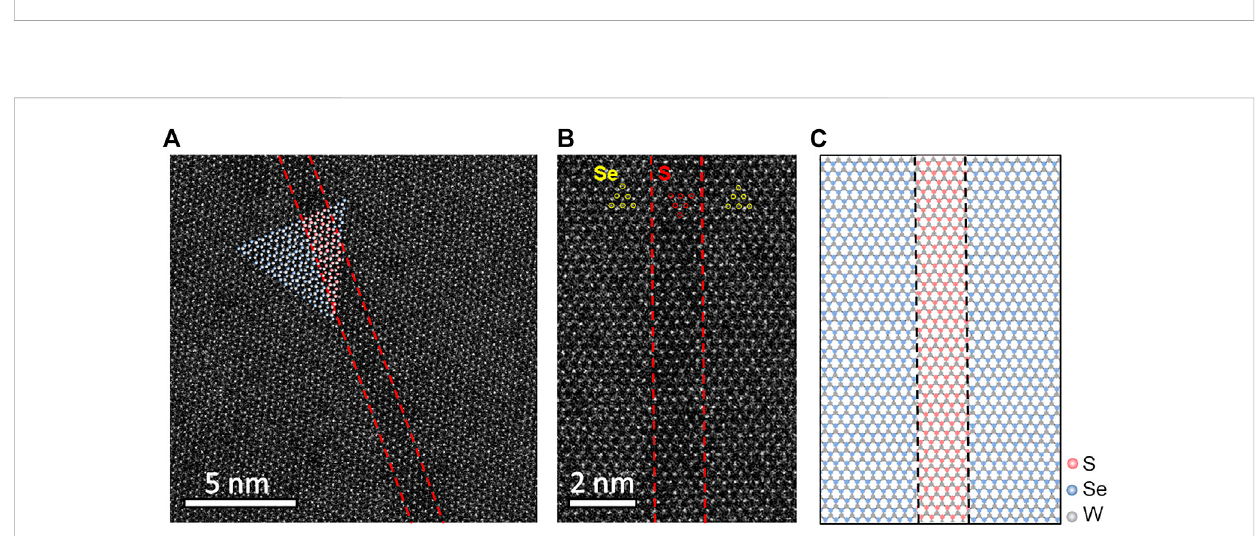
FIGURE 3 Atomic-scale sharp WS 2 2D quantum well embedded inmonolayer WSe 2 . (A) STEM image oftheWSe 2 /WS 2 lateral heterojunctioninterface; the red dashed line highlights the interface between WSe 2 and WS 2 . (B) High-resolution STEM-ADF image of a WS 2 quantum well; the red dashed line along the armchair orientation highlights the interface between WSe 2 and WS 2 . The yellow and red circles mark the Se and S atoms, respectively. (C) Atomic structural model of the WS 2 quantum well corresponding to (B) . Pink, blue, and gray spheres represent the S, Se, and W atoms,